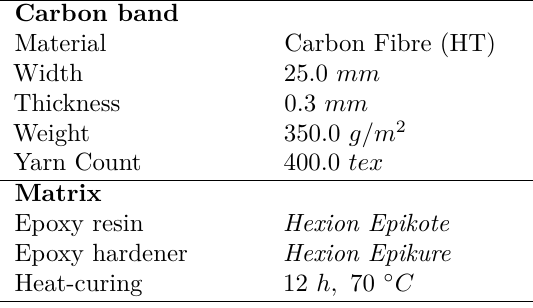
Table 3. The composite material used.